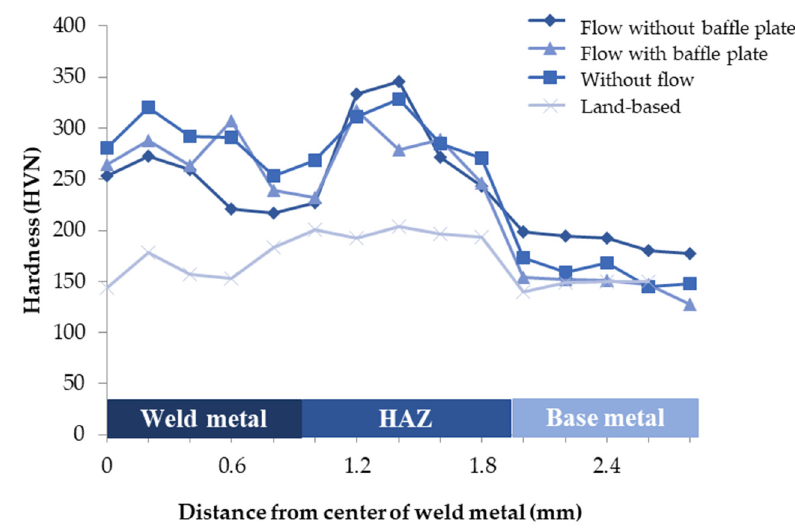
Figure 18. Graph of hardness testing of welded specimens.